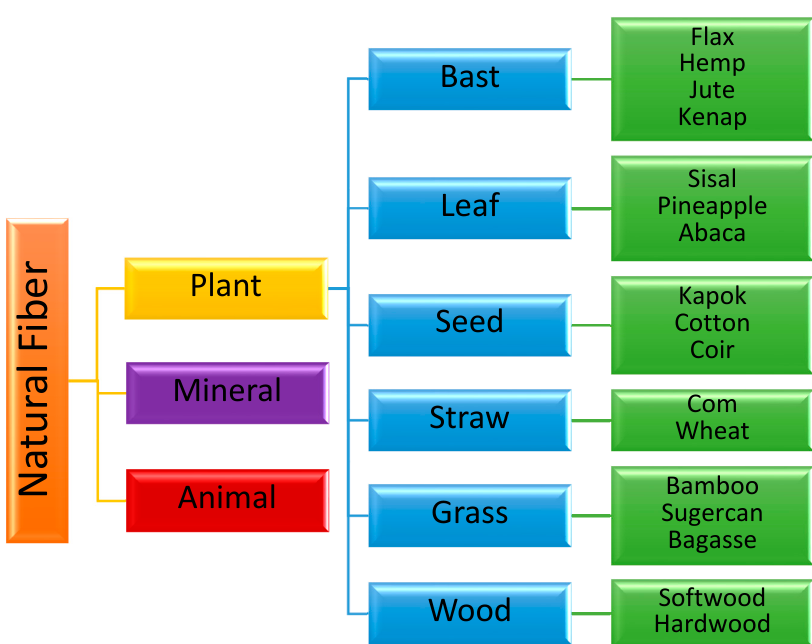
Figure 2. Schematic representation of natural fibers.